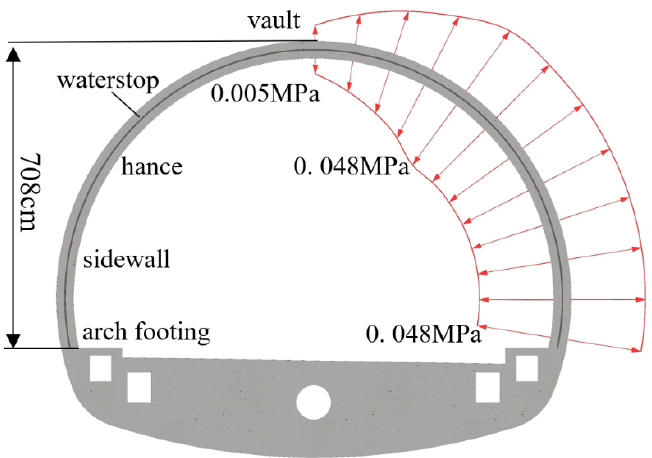
Figure 7. The initial contact pressure of the waterstop.